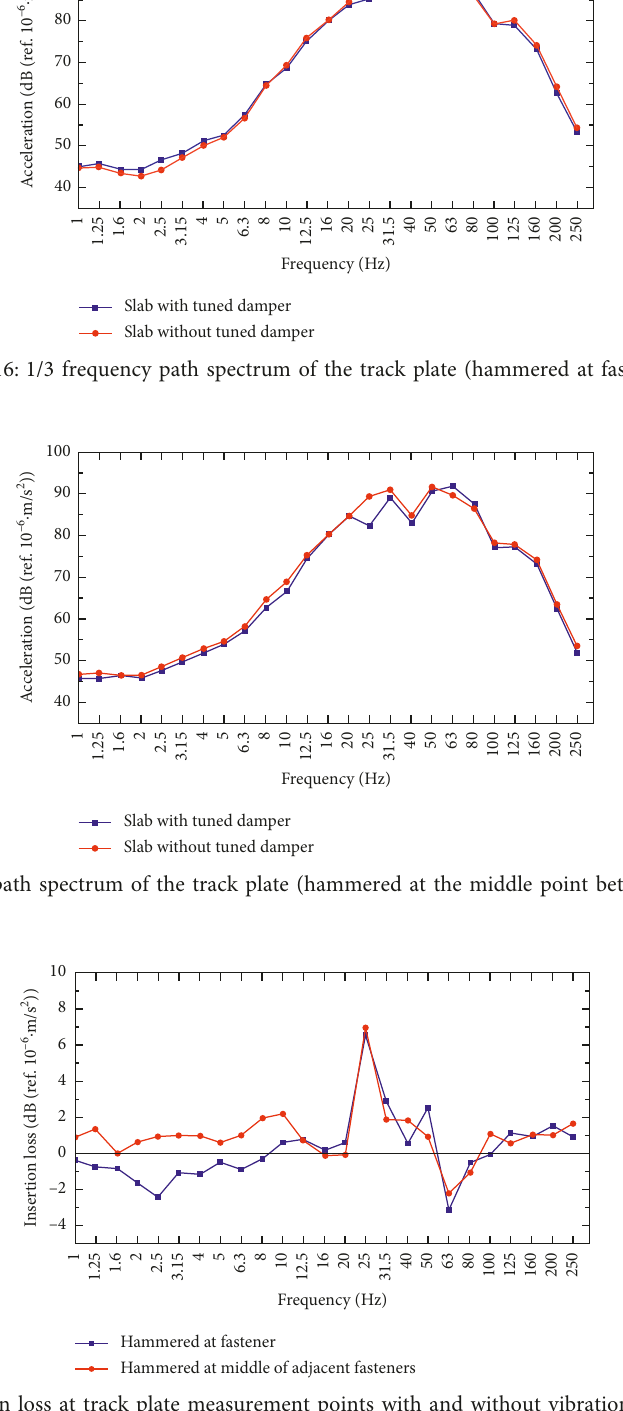
Figure 18: Insertion loss at track plate measurement points with and without vibration absorbing